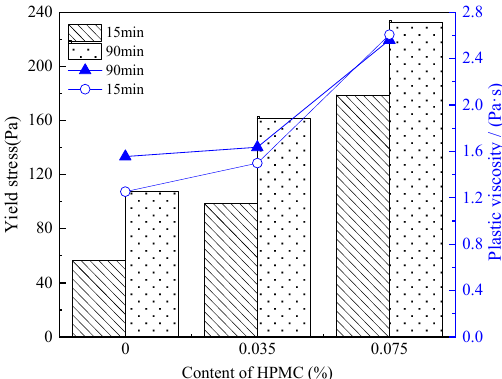
Figure 11. Yield stress and plastic viscosity of C-HPMC pastes.